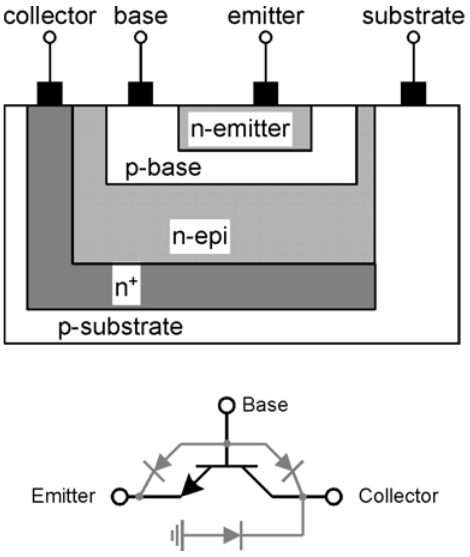
FIGURE 8 Bipolar transistor structure.